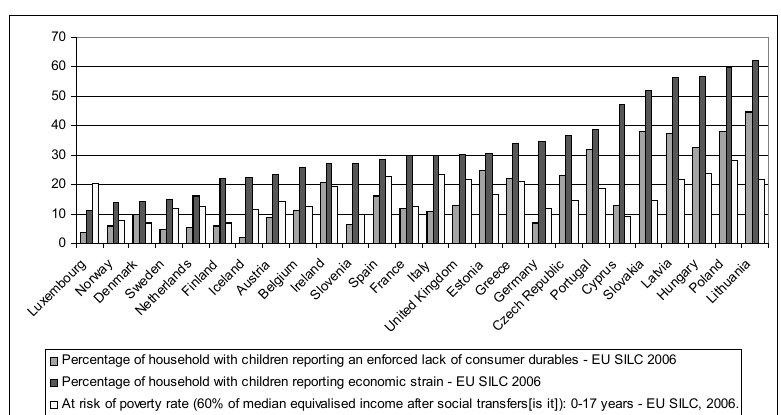
Figure 9 : Child poverty rates in EU 29 (deprivation, economic strain and relative income poverty) 2006. Ranked by economic